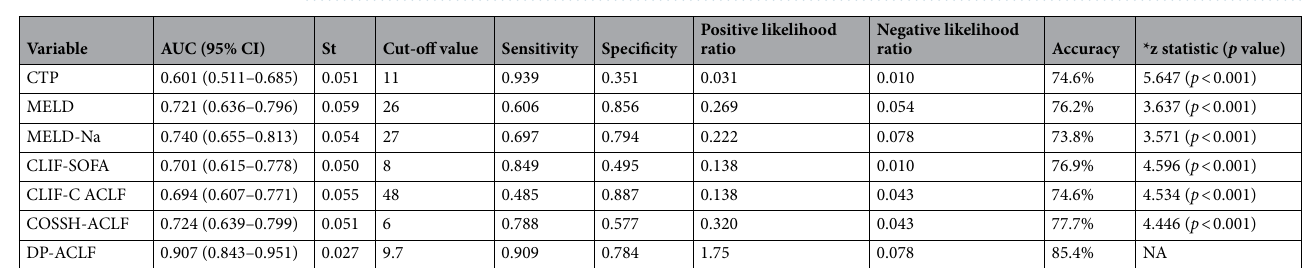
Table 6. Validation group: ROC correlation analysis and comparison of DP-ACLF and other prognostic scores.